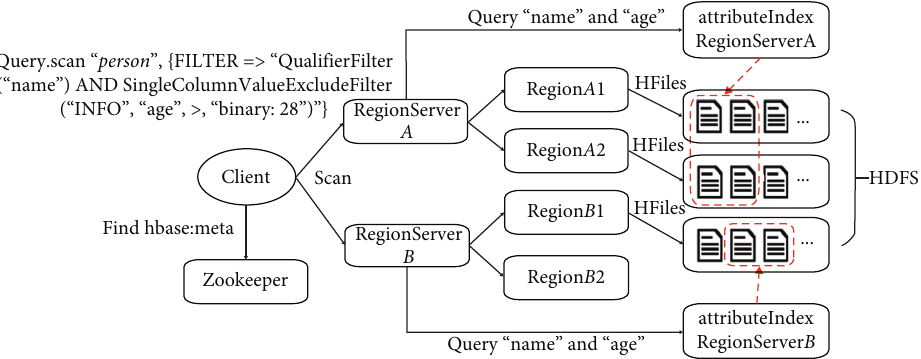
Figure 9: The process of building an